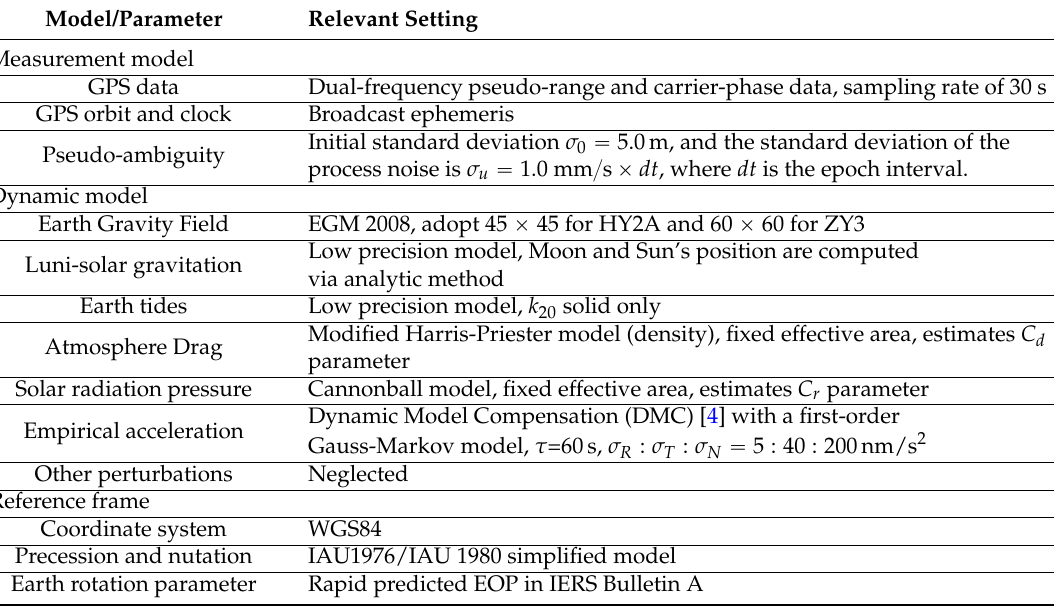
Table 1. Models and Parameters Setting of SATODS.